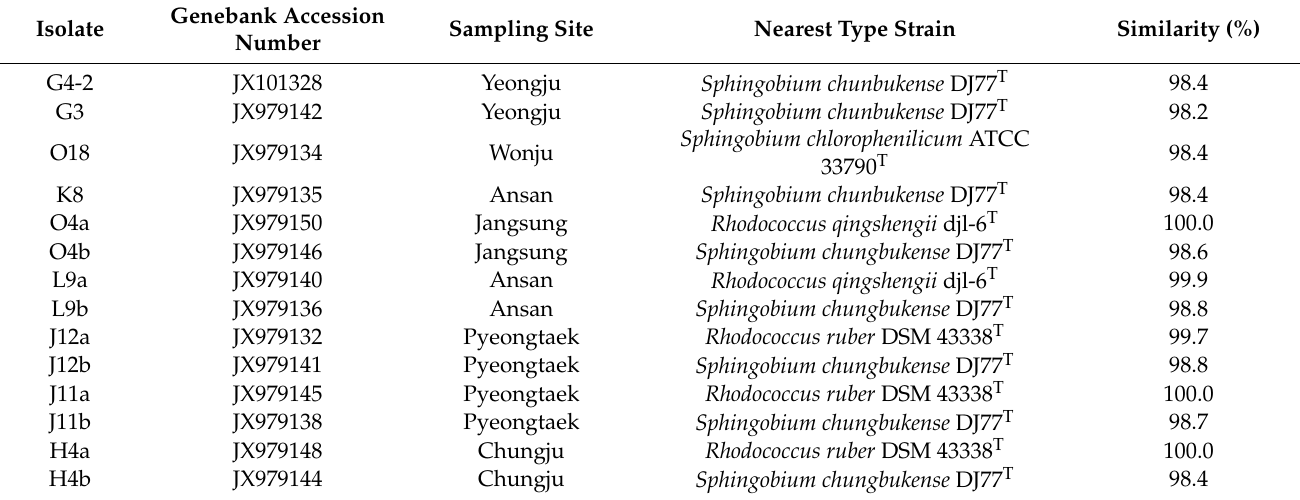
Table 1. Nearest relatives of the butachlor-degrading isolates based upon 16S rRNA gene sequences.